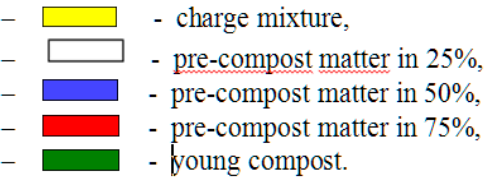
Figure 3. Quality conditions of the compost.